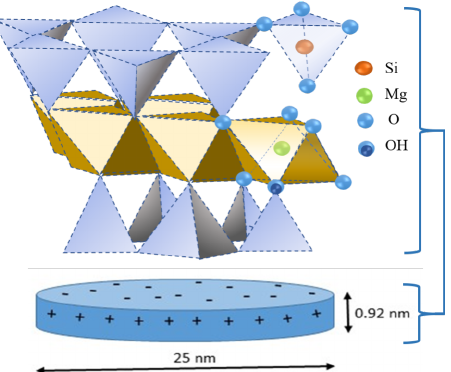
Figure 1. Illustration of the LAP nanoscystal geometry (disk shape) and chemical structure. The circular surfaces of the crystal posses a negative charge due to substitution of Mg 2+ by Li + in octahedral layer of the crystal. The edges have a positive charge depending on the protonation of the exposed hydroxyl